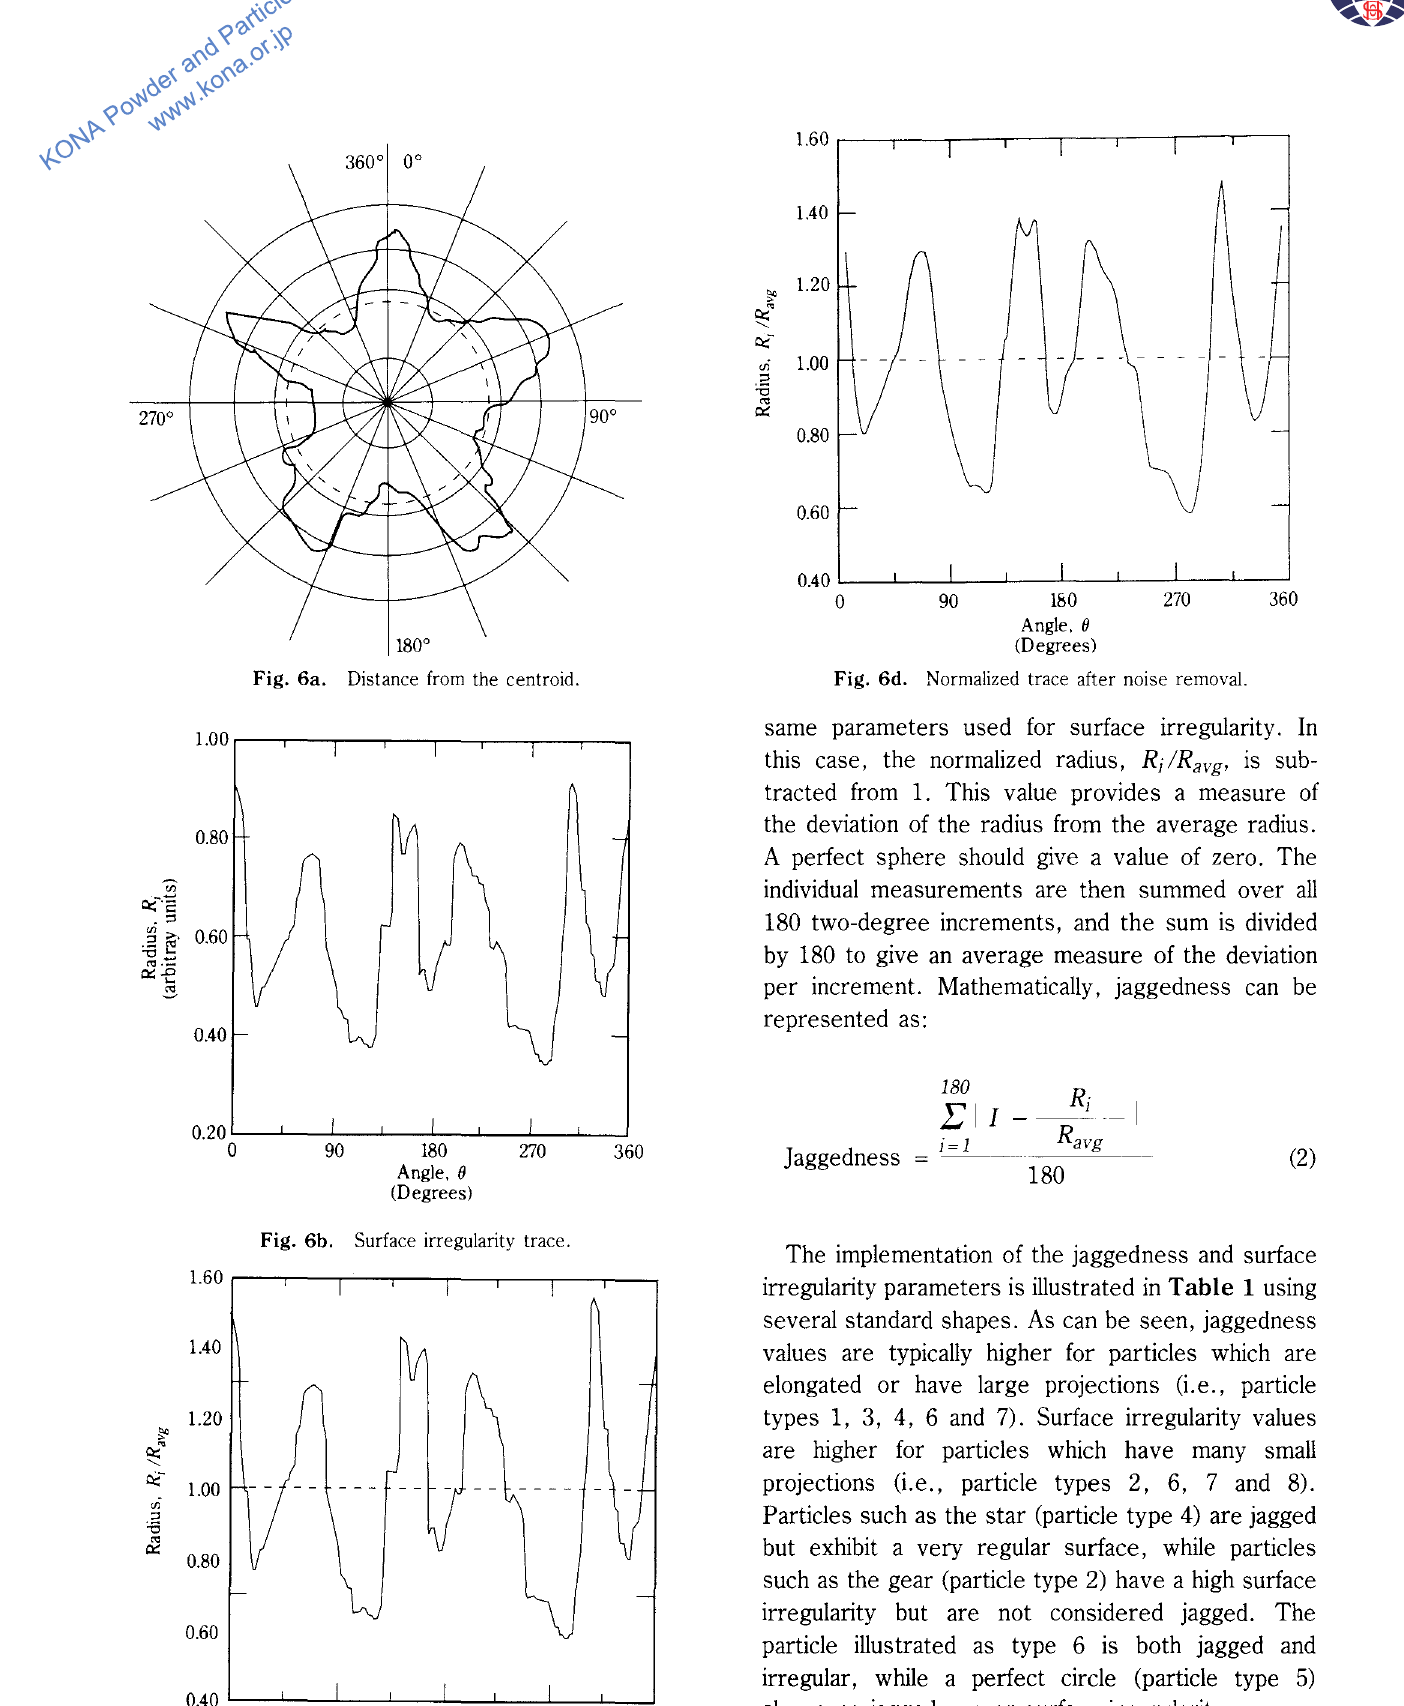
Fig. 6c. Normalized surface irregularity trace.